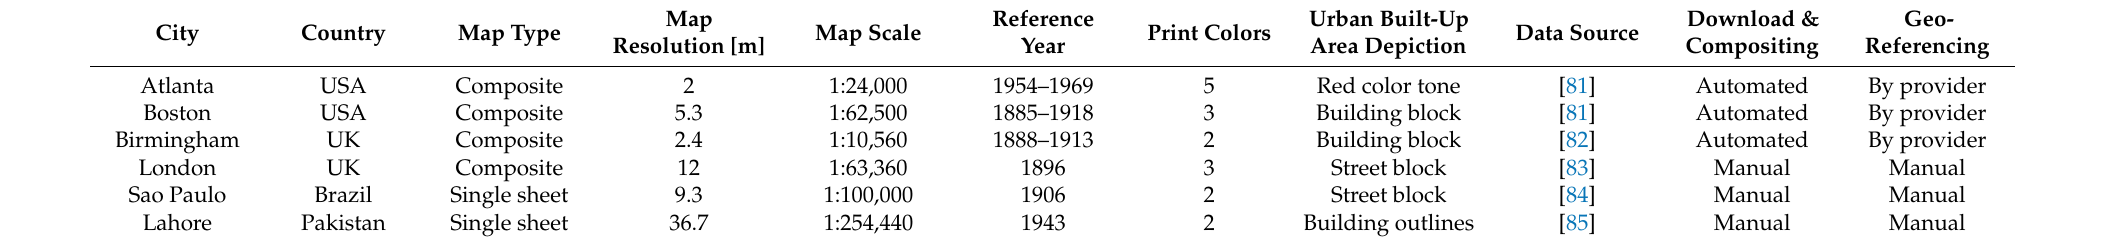
Table 1. Overview of the six historical maps/map composites used in this study and their